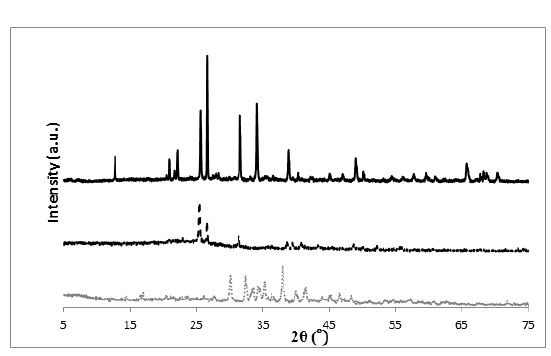
Figure 1. XRD spectra (-) AC(ZnCl